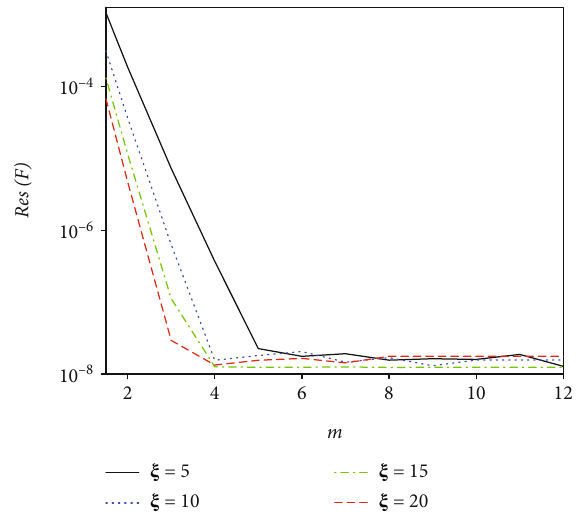
Figure 23: Variation of residual error Res ð Θ Þ against increasing order ð m Þ of LSPM series approximation for di ff erent values the R = 0 : 6, Ω = 0 : 6, andHe = 0 : 2 : non-similar parameter ξ , when n = 0 : 5, K = 0 : 5, Pr = 10, S = 3, N